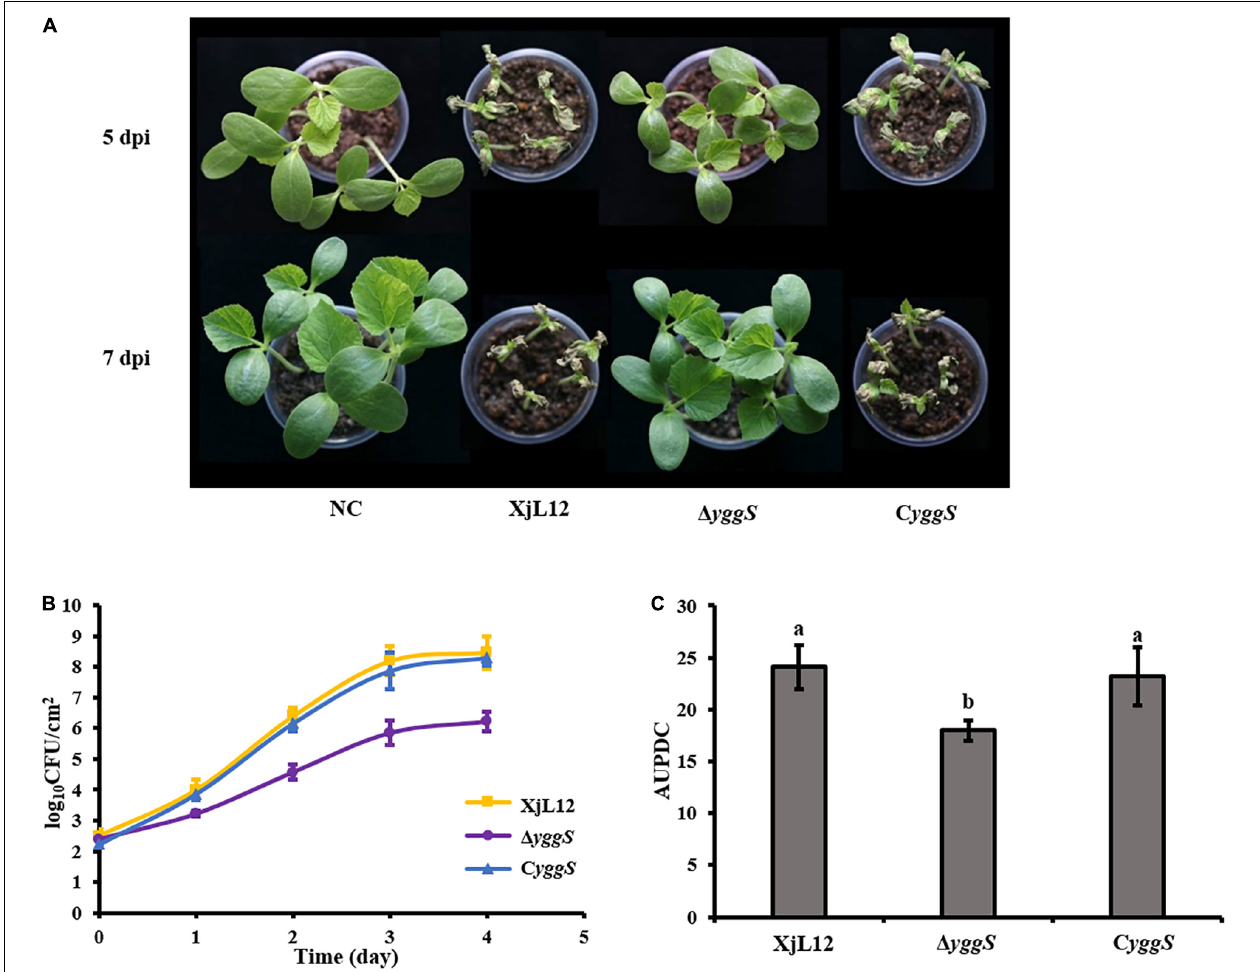
FIGURE 3 | Effect of yggS on the ability of A. citrulli to colonize in melon cotyledons. (A) A. citrulli cell suspensions ( ∼ 1 × 10 4 CFU/mL) were injected into the cotyledons of melon seedlings. The images represent seedling symptoms at 5 and 7 days post-inoculation (dpi). (B) The melon cotyledons were injected with bacterial suspensions ( ∼ 1 × 10 5 CFU/mL) and the bacterial populations were quantified for five days. (C) Histogram of area under population dynamics curve (AUPDC) calculated for A. citrulli colonization of cotyledons. In the graph, the data points represent means and the tines represent the standard errors of the mean. In the histogram, the bars represent means and lines indicate the standard errors of the mean. XjL12: wild-type strain, (cid:49) yggS : yggS deletion mutant; C yggS : complemented strain of (cid:49) yggS . Letters above the bar represent significant differences as determined by the LSD test ( P < 0.05).